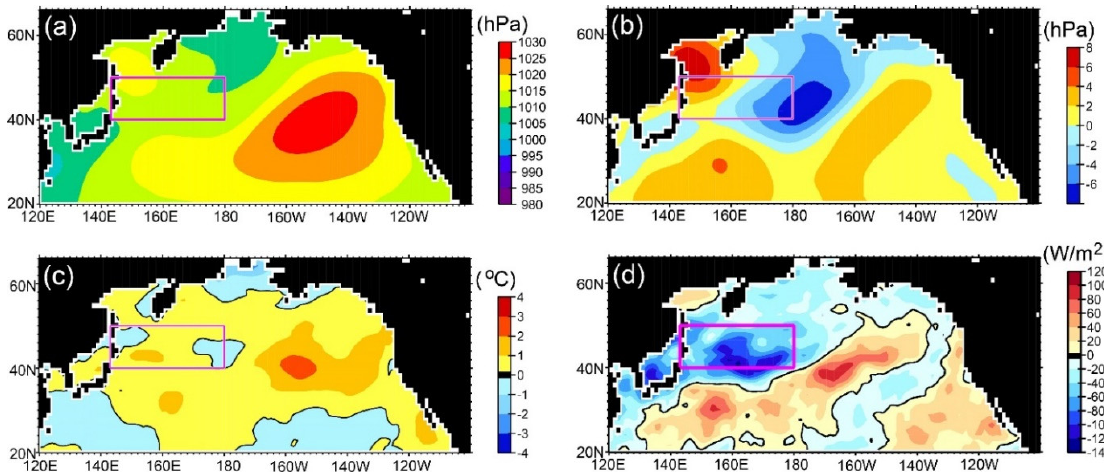
Figure 10. ( a ) Sea level pressure during 1–18 August 2021. Anomalies during the same period: ( b ) sea level pressure, ( c ) air temperature at 2 m above the sea surface, and ( d ) net heat flux at the sea surface.